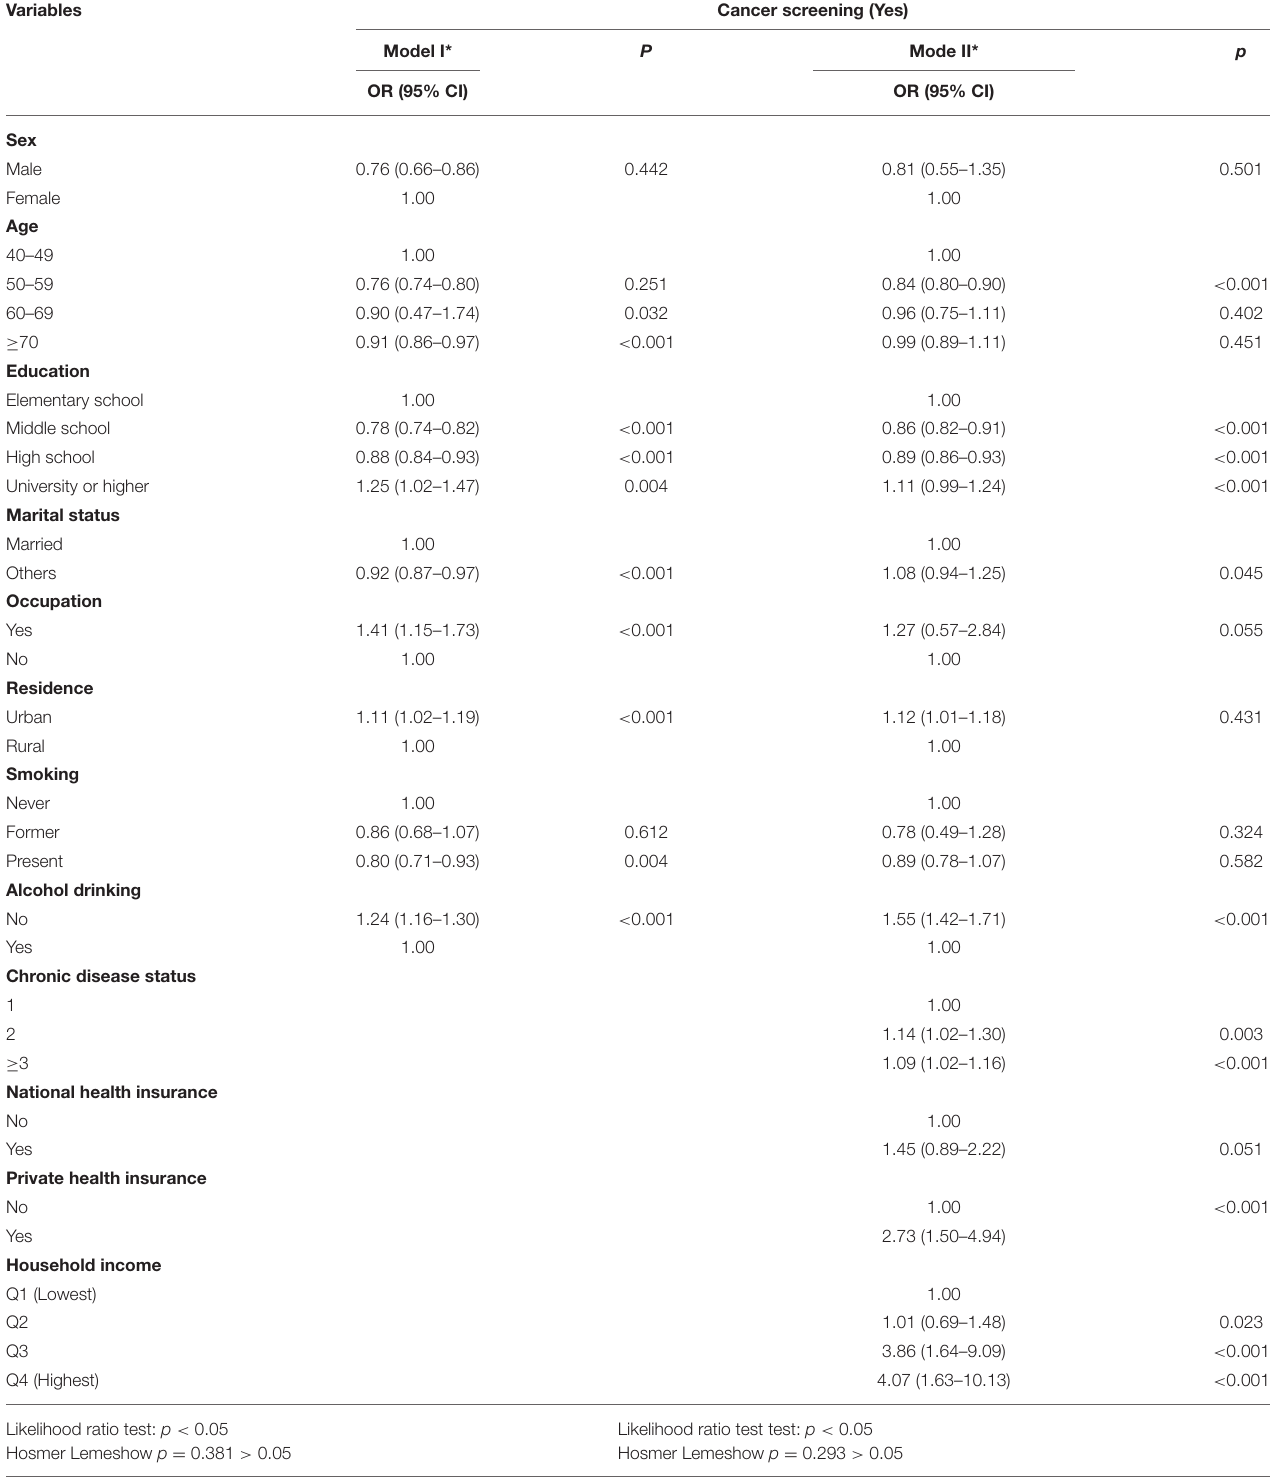
TABLE 3 | Multivariate logistic regression of factors associated with cancer screening. Variables